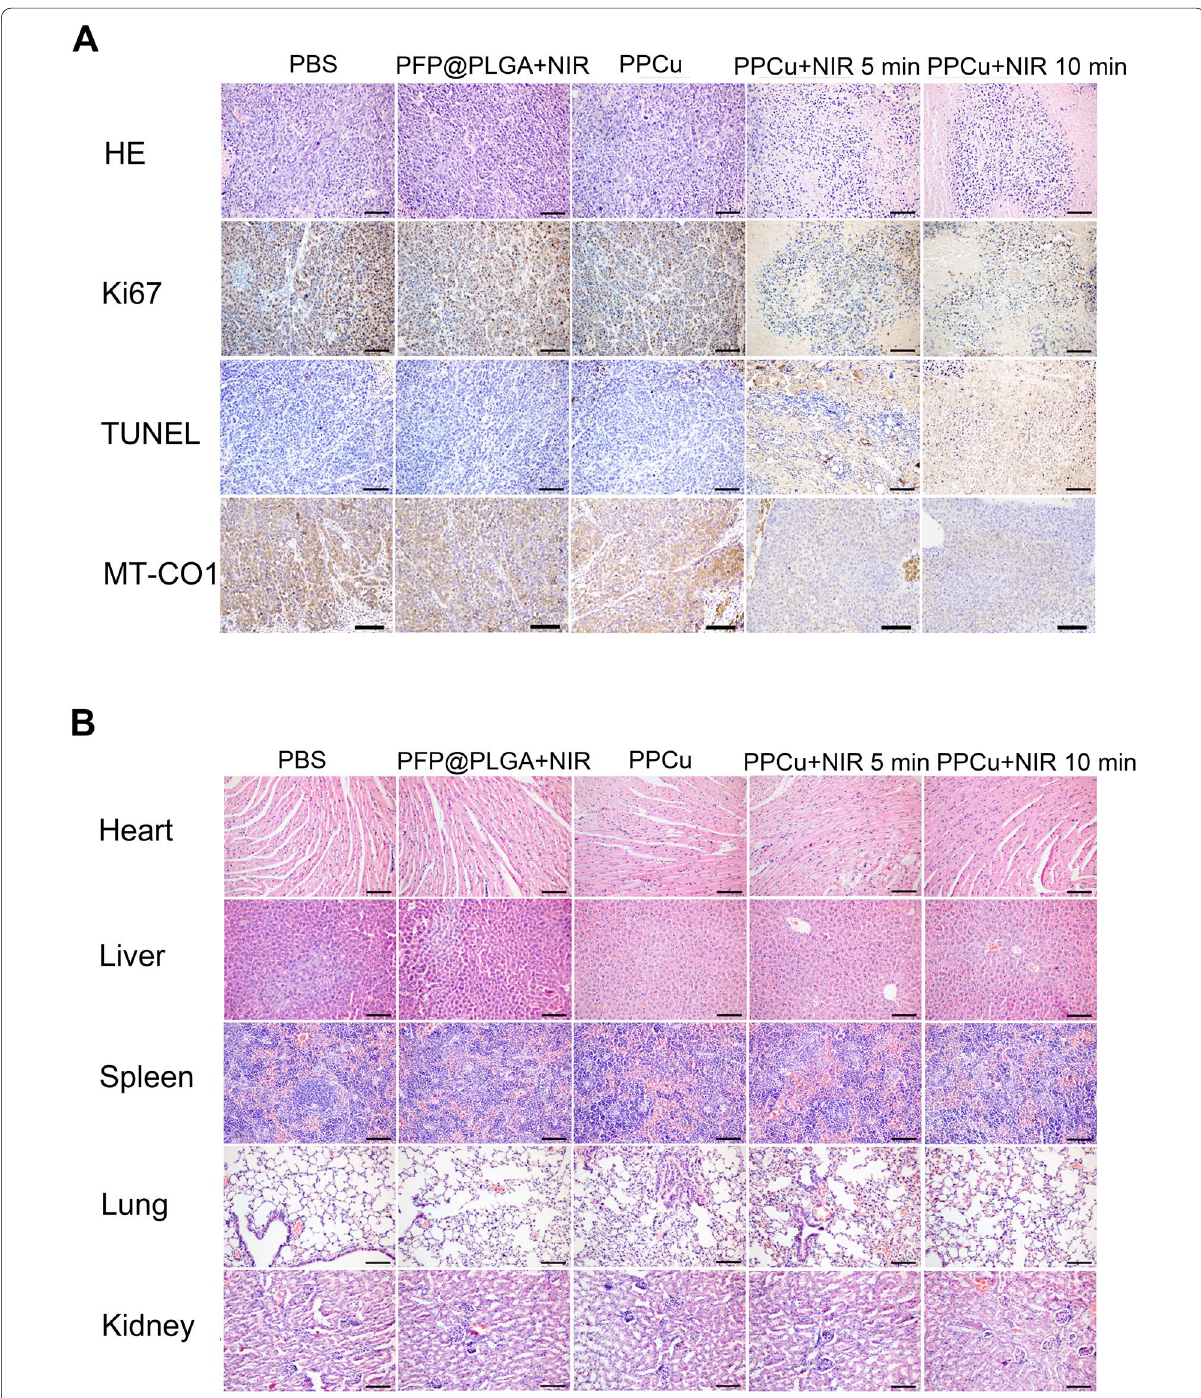
Fig. 9 Mechanistic analysis of PTT with PPCu. A H&E, ki67, MT-CO1 and TUNEL staining of tumor regions in every group. Scale bar staining of heart, liver, spleen, lung and kidney collected from different groups of mice at the 14th day after different